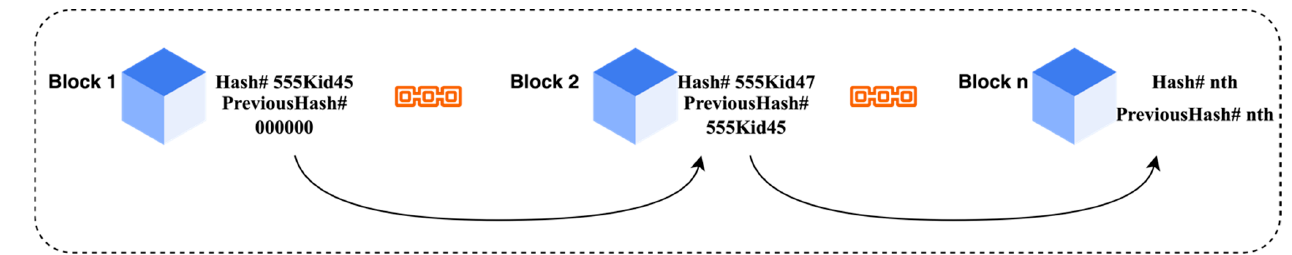
Figure 1. Blockchain